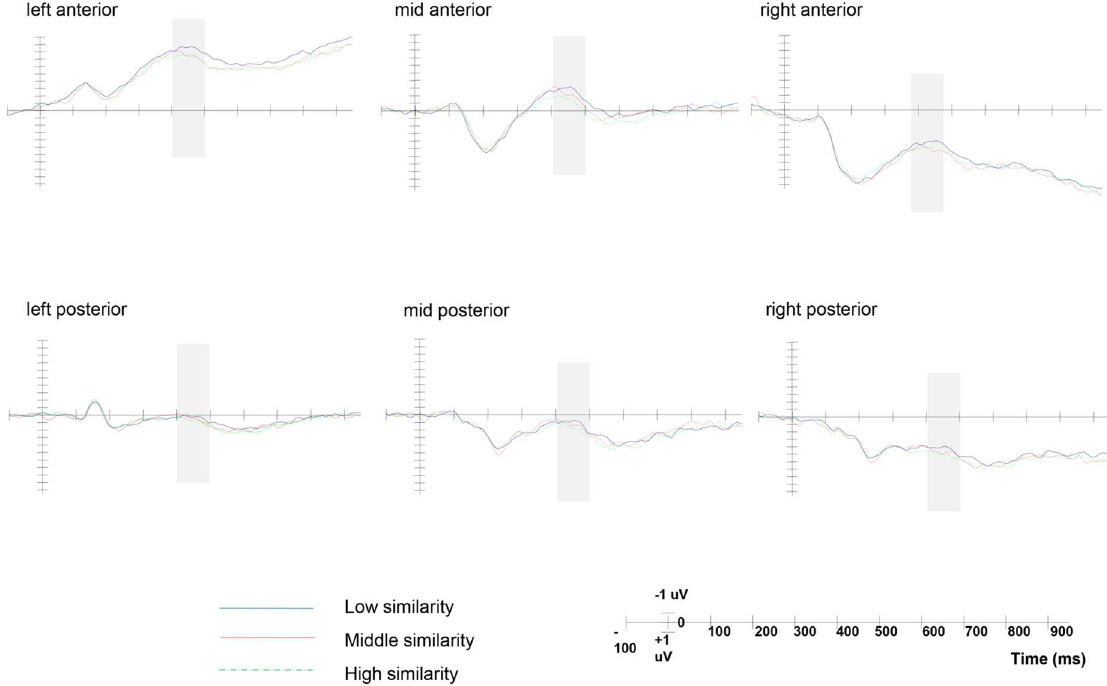
Fig 4. Grand average ERPs at six ROIs in Experiment 2 (400–500ms). The origin of the time-axis (0ms) is placedat the onset of the target word, ERPs elicited in the low similarity condition(dotted line) were significantlymore negative than the high similarity condition(solid line) in the 400- to 500-ms interval after middle word onset across six ROIs (light grey shading), indicatingthe shape attribute of the word was activated during encoding.